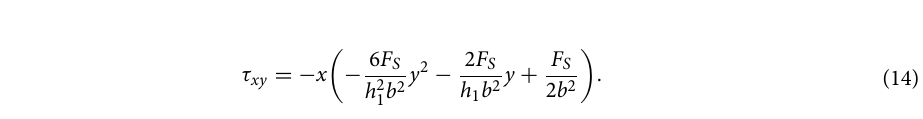
Figure 10. ( a ) Maximum principal stress and ( b ) minimum principal stress distribution of the main rock mass with the middle thick